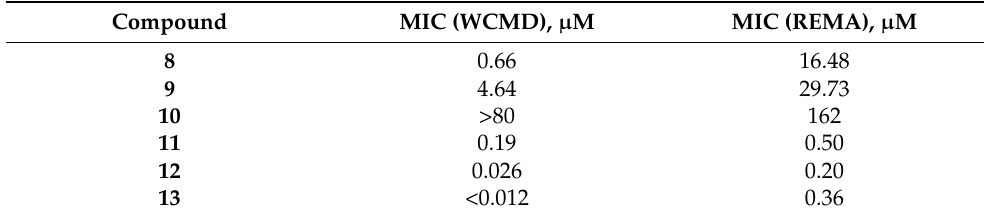
Table 1. MIC values of the tested compounds by two different methods, WCMD and REMA.